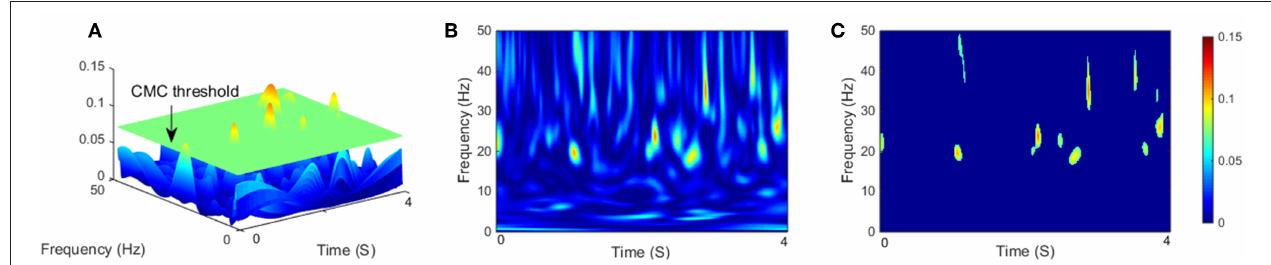
FIGURE 2 | (A) Three-dimensional representation of CMC on the time-frequency plane with a segment length of 4s, the green flat indicated threshold of significant coherence, and the magnitude of CMC was quantified as the area exceeded the threshold level. (B) Two-dimensional empirical wavelet coherence ˆ R 2 XY ( w , s ) using CWT on the time–frequency plane. (C) Two-dimensional significant coherence ˆ R 2 SCS ( w , s ), represents significant areas of B